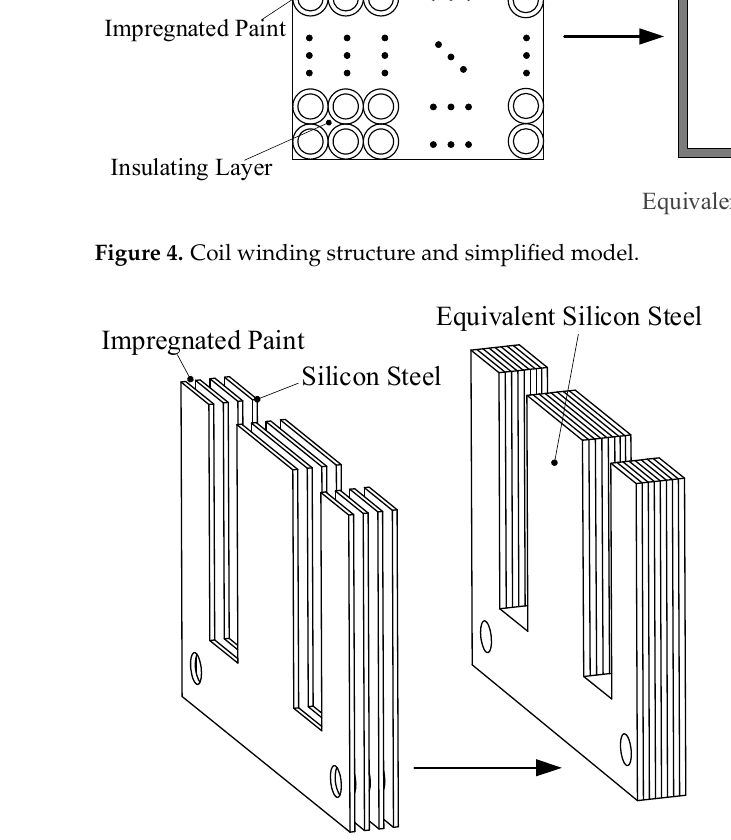
Figure 4. Coil winding structure and simplified model.